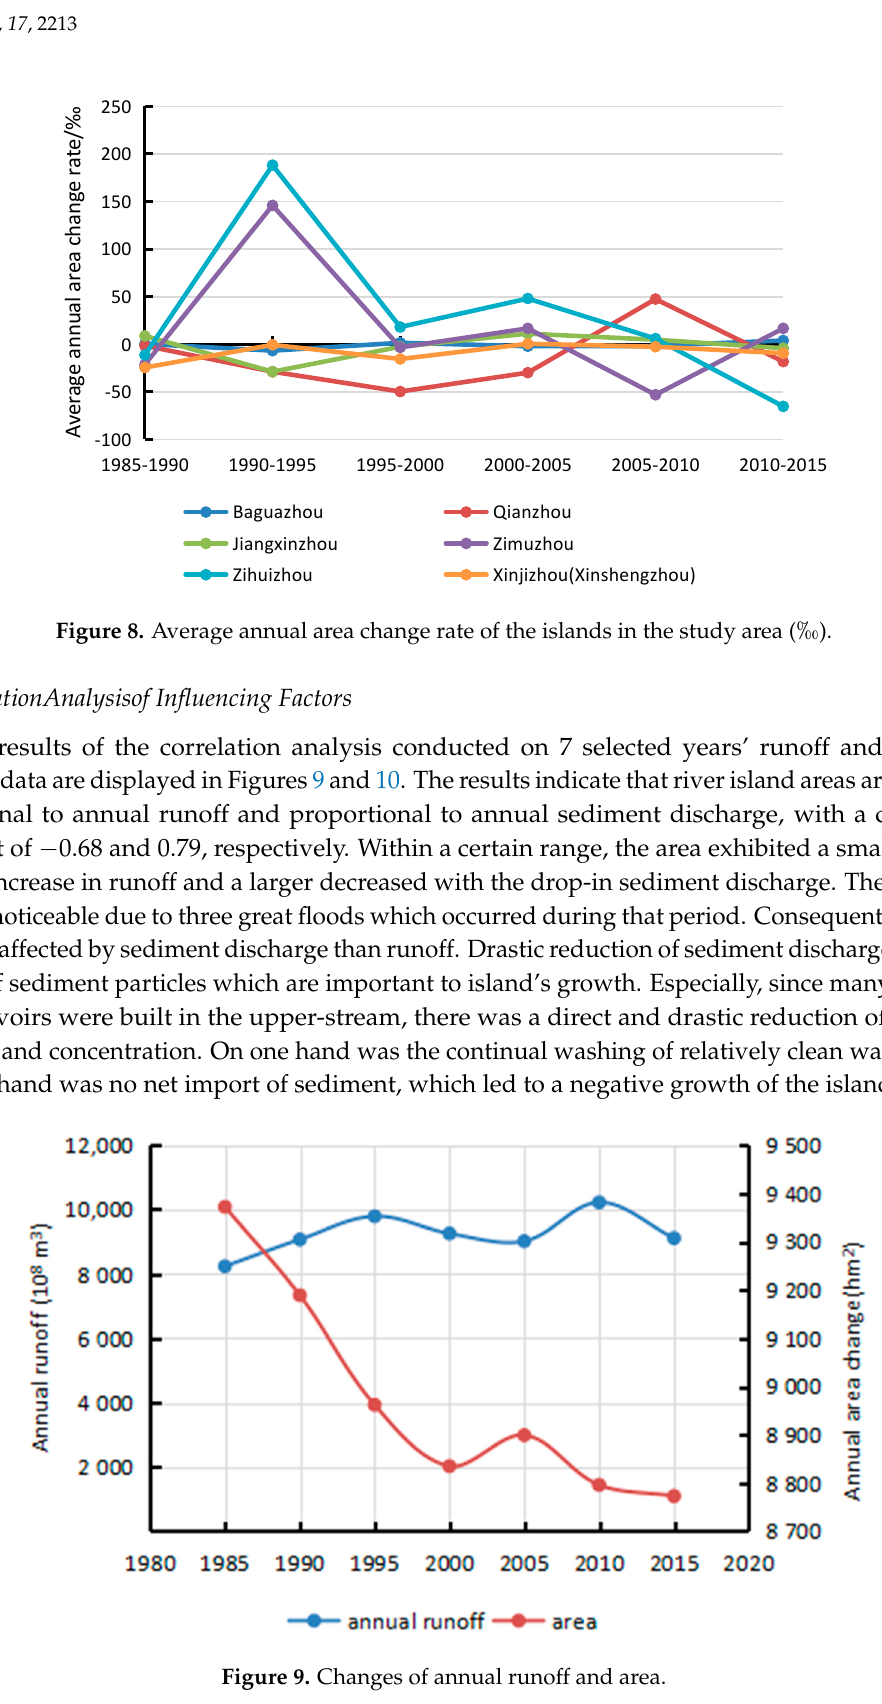
Figure 9. Changes of annual runoff and area.